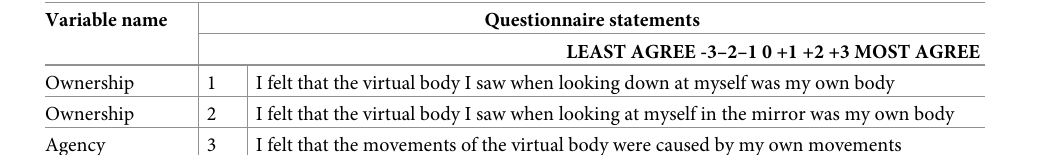
Table 1. Ownership illusion questionnaire